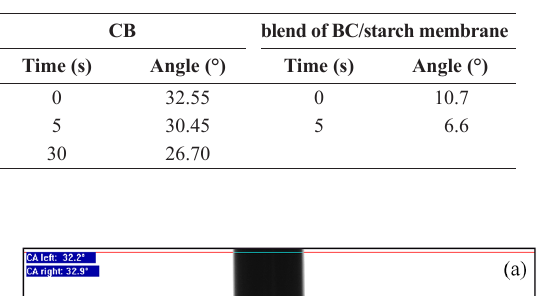
Table 2. Time and contact angle for pure BC membrane and blend of BC/starch membrane.